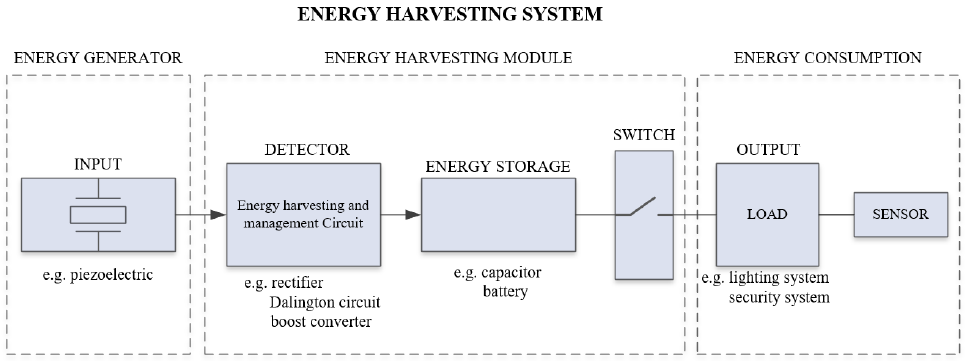
Figure 4. Overall working of piezoelectric energy harvesting system.